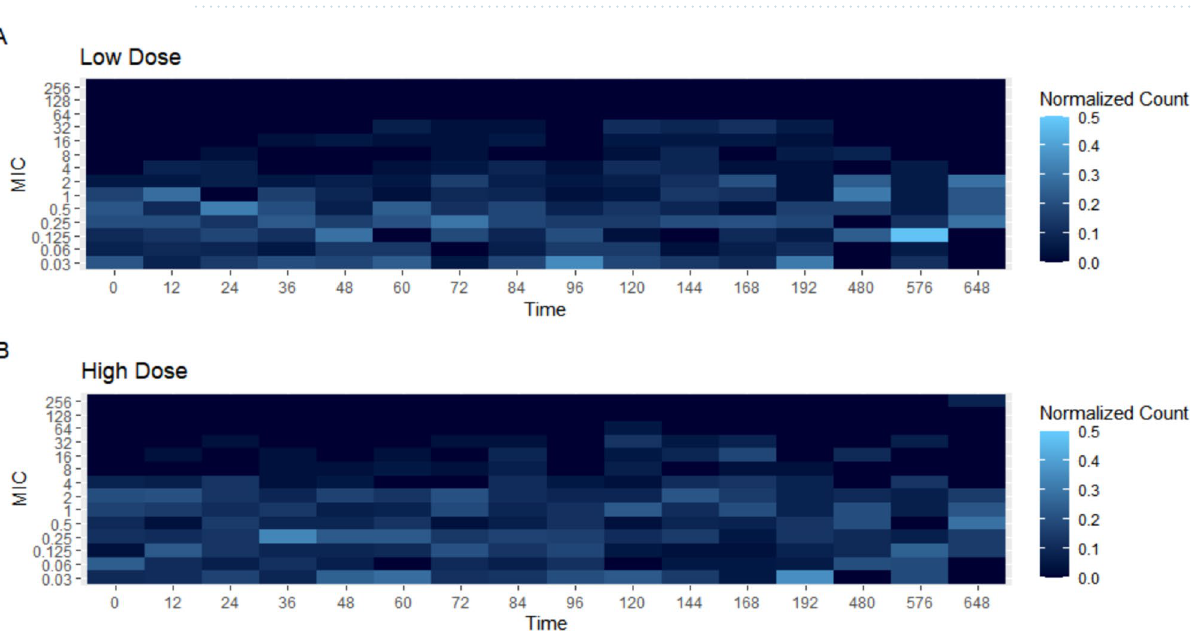
Figure 4. Heat Map demonstrating the number of E. coli isolates per each MIC value over time for both the low dose ( A ) and high dose group ( B ).